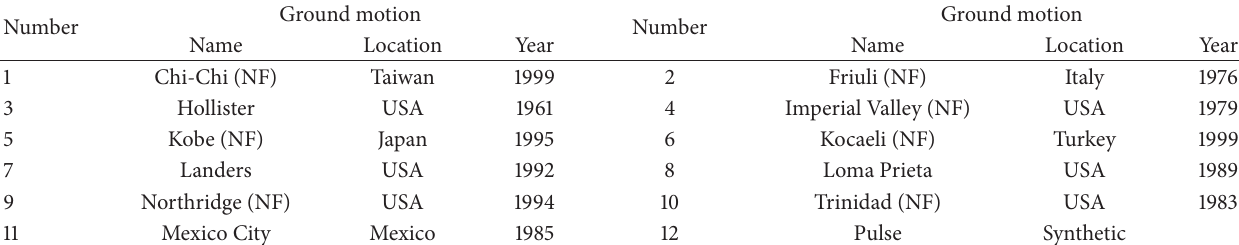
Table 1: Ground motions of the present study. The NF stands for near-fault ground motion.